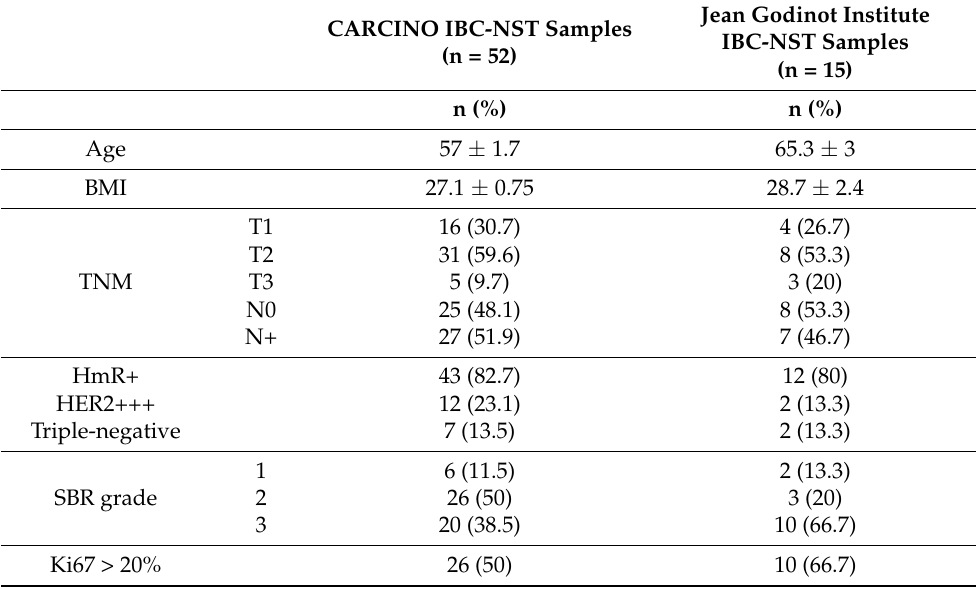
Table 2. Characteristics of the cohort of Invasive breast carcinoma of no special type (IBC-NST) samples from the CARCINO study and the Jean Godinot Institute cancer center. Data are quoted as the mean ± SD or n (%). BMI: body mass index, T: tumor size (T1: ≤ 20 mm; T2: 20–50 mm; T3: 50 mm). N: regional lymph nodes (N0: no lymph node invasion, N+: lymph nodes invaded). HmR: hormone receptor. SBR: